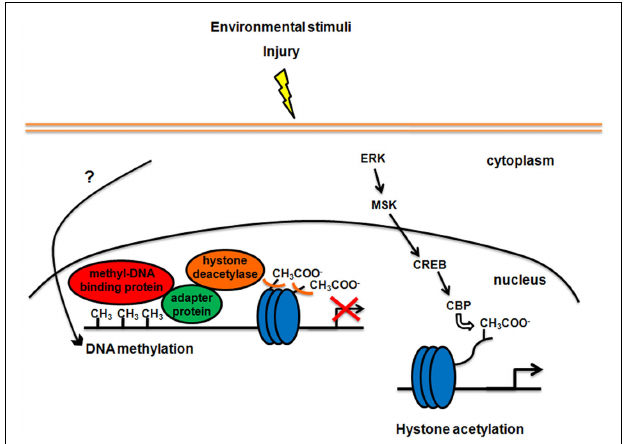
FIGURE 1 | Modifications of chromatin structure in response to enriched environmental stimulation or injury in the mature CNS. On the left side of the figure, DNA methylation-dependent gene silencing is shown. Signaling pathways between neuronal activity and DNA methylation are still unclear. Methylation of specific sites in the genome recruits methyl-DNA binding proteins locally. All proteins that bind to methylated DNA also have a transcription-regulatory domain, which binds to adapter proteins, which in turn recruit histone deacetylases. Histone deacetylases alter chromatin structure through removal of acetyl groups (CH 3 COO − ) from histone core proteins (blue circles), leading to compaction of chromatin and transcriptional suppression. On the right side of the figure, the signaling pathway involving ERK, MSK, and CREB, implicated in the control of histone acetylation and chromatin structure, is shown. Phosphorylation and thus activation of CREB recruits CREB binding protein (CBP), which has histone acetyltransferase activity and leads to activation of gene